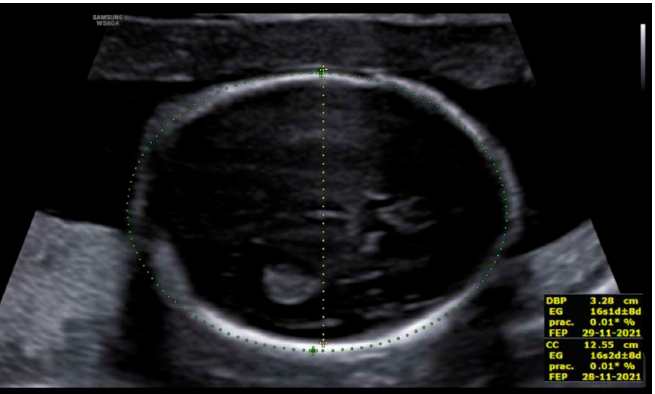
Figure 2. Axial view of midline with non-visualization of the CSP, showing directly the columns of the fornix. Additionally, we can observe microcephaly. Measurements corresponding to a gestational age of 16 weeks.